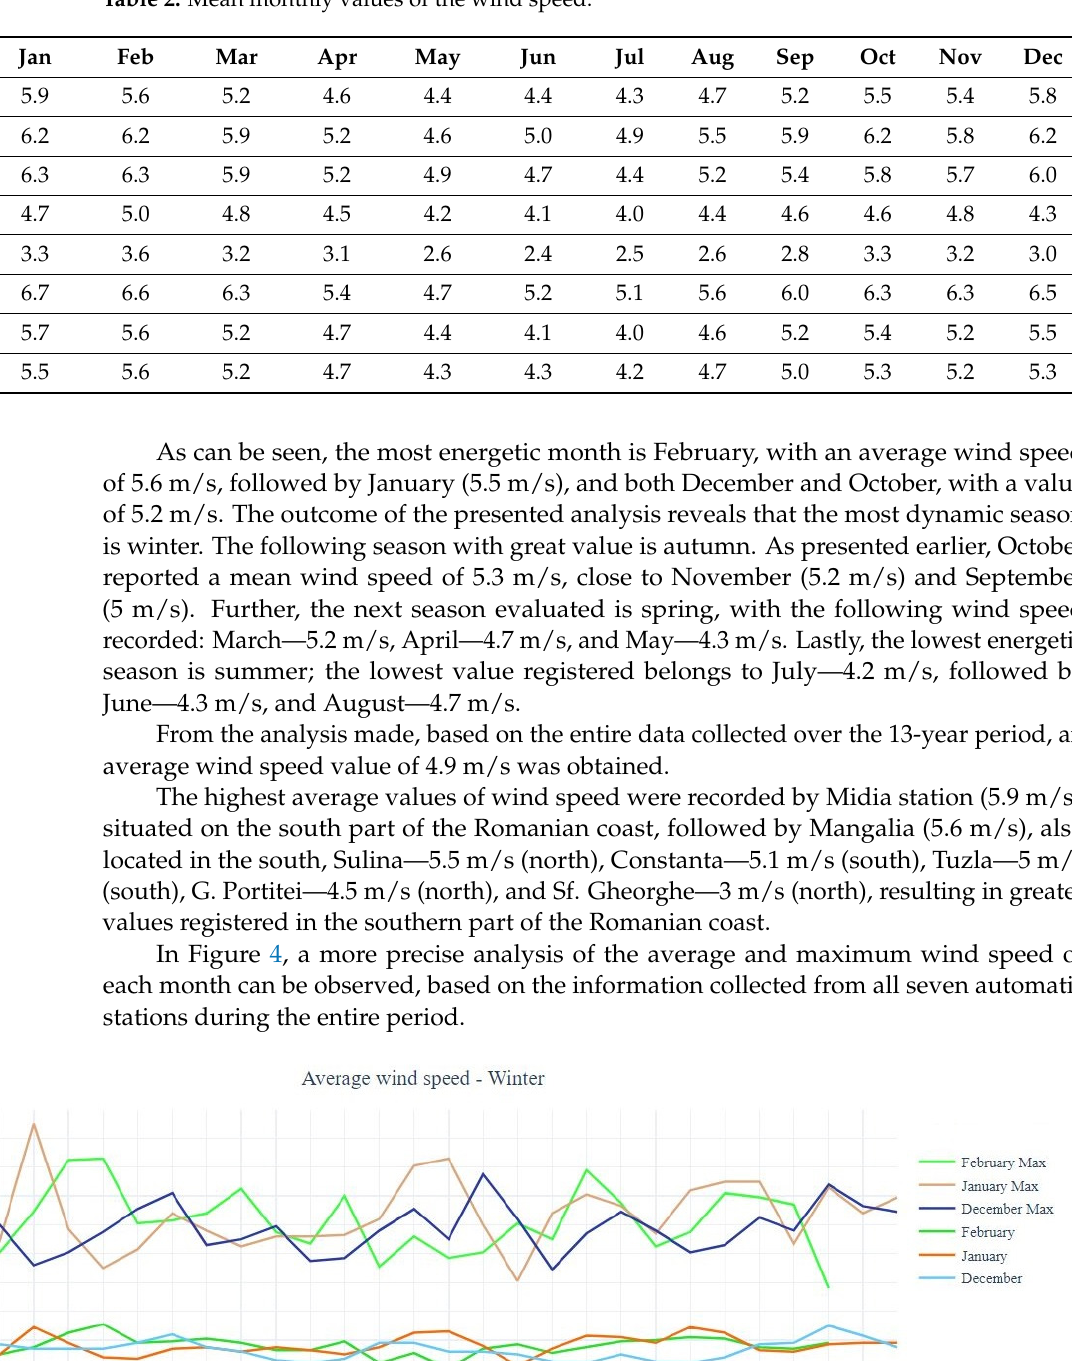
( b ) ( c ) ( d ) Figure 4. Monthly wind speed analysis; ( a ) winter; ( b ) spring; ( c ) summer; ( d ) autumn.